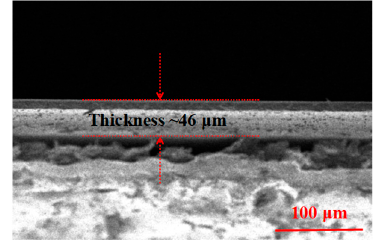
Figure 5. The SEM image of the Cr 2 Ge 2 Te 6 ‐ PVA film.